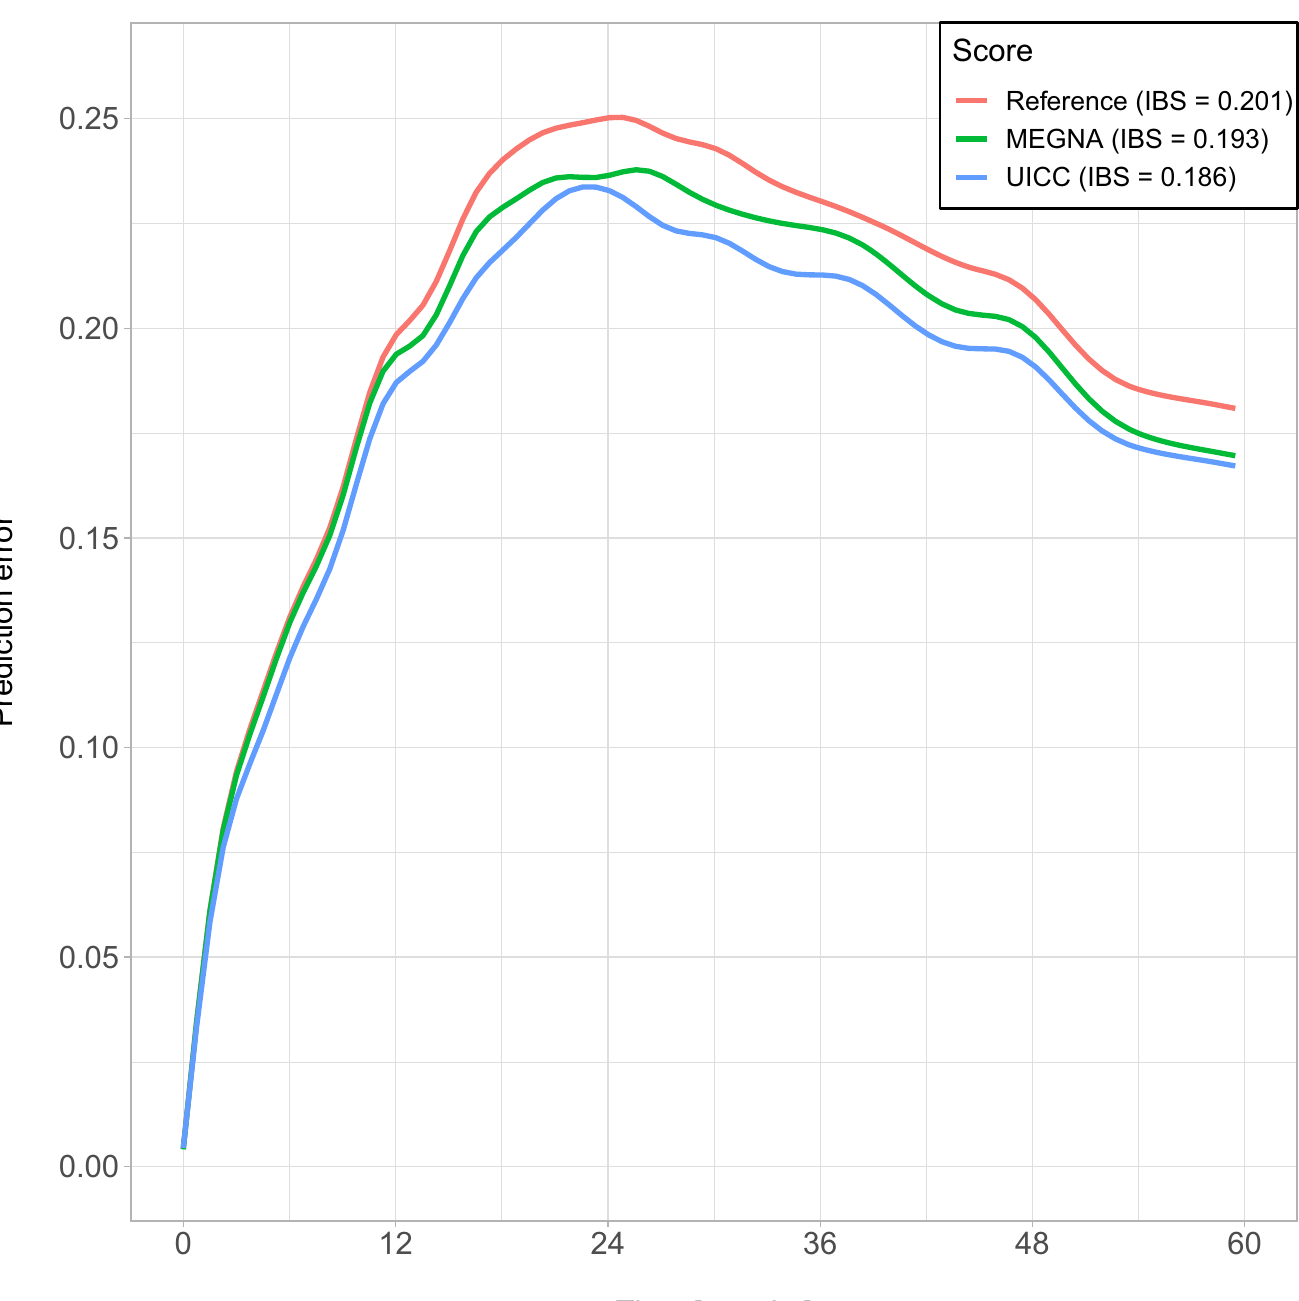
Fig 4. Smoothed prediction error curves and integrated Brier Scores (IBS) for Kaplan Meier estimates based on the MEGNA and UICC stratification as well as on estimates for all patients without any stratification (Reference curve).